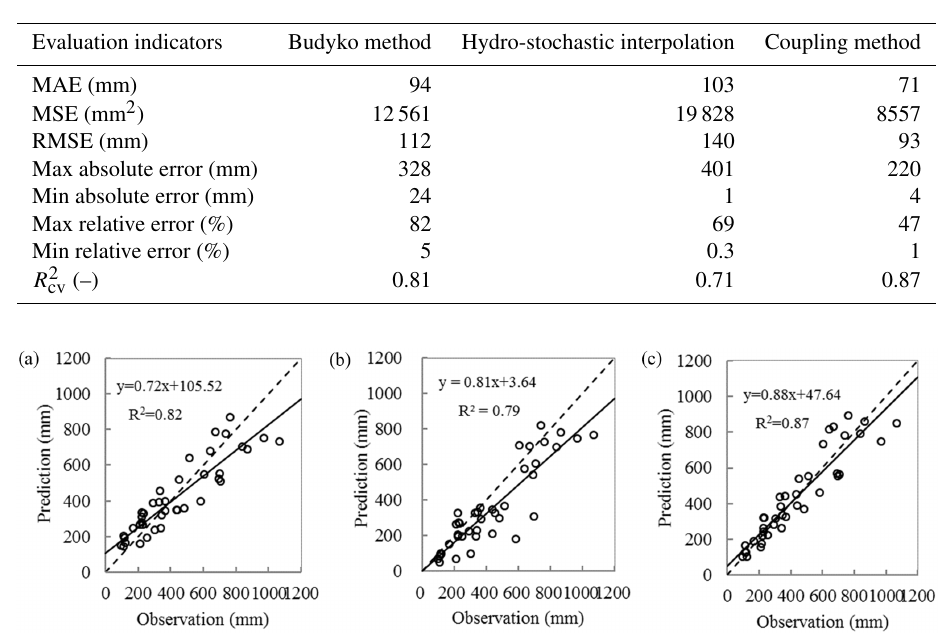
Table 2. Interpolation cross-validation errors between the predicted and observed runoff in the 40 sub-basins in the HRB from the three methods.